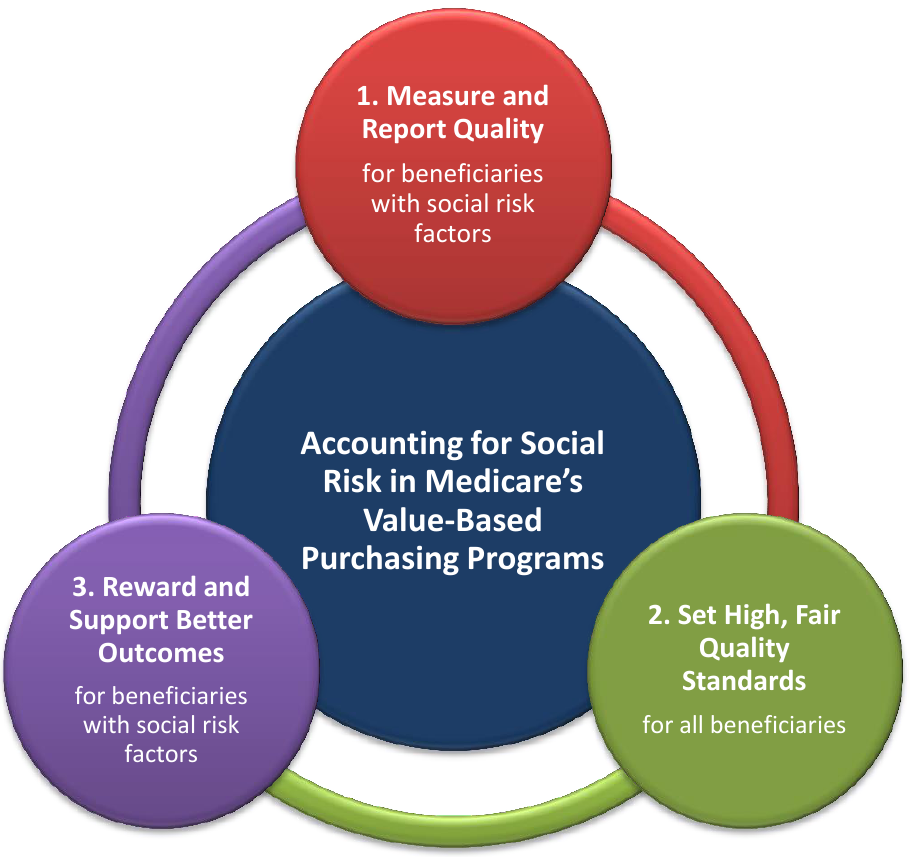
Figure 1. Strategy for Accounting for Social Risk in Medicare’s Value-Based Purchasing